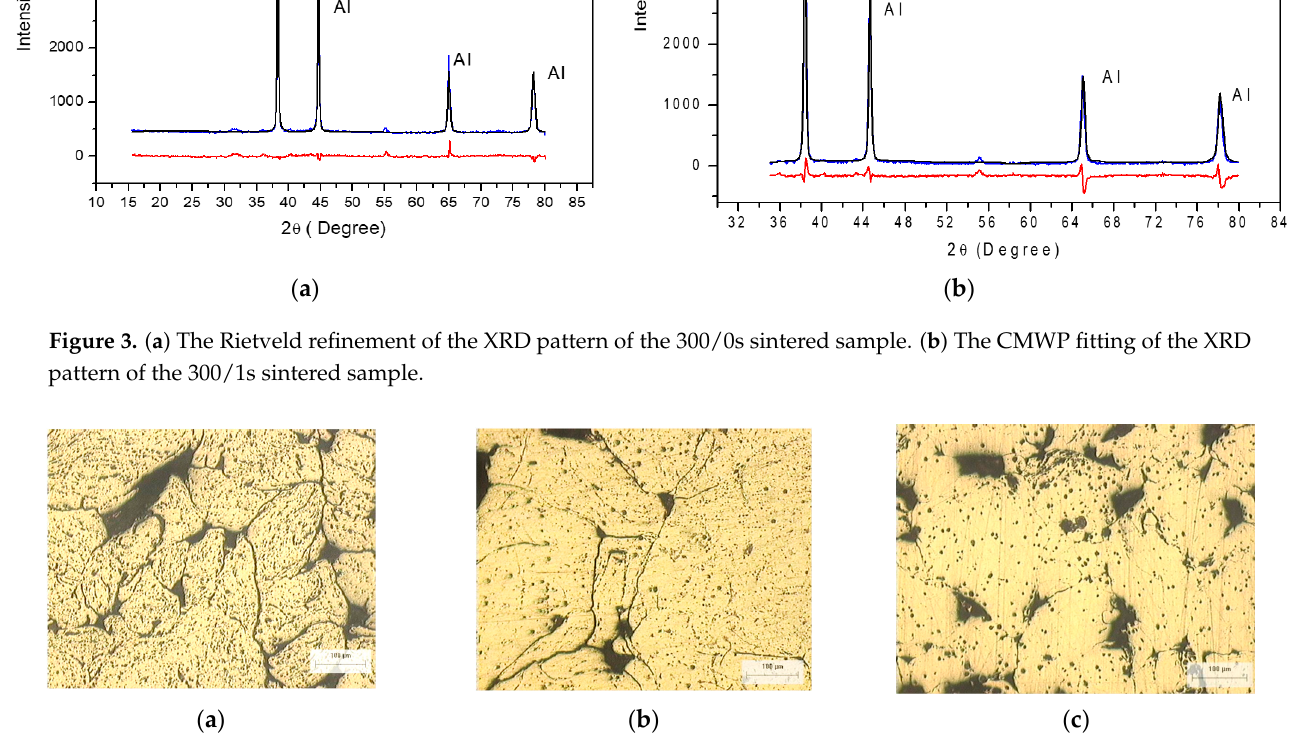
Figure 3. ( a ) The Rietveld refinement of the XRD pattern of the 300/0s sintered sample. ( b ) The CMWP fitting of the XRD pattern of the 300/1s sintered sample.